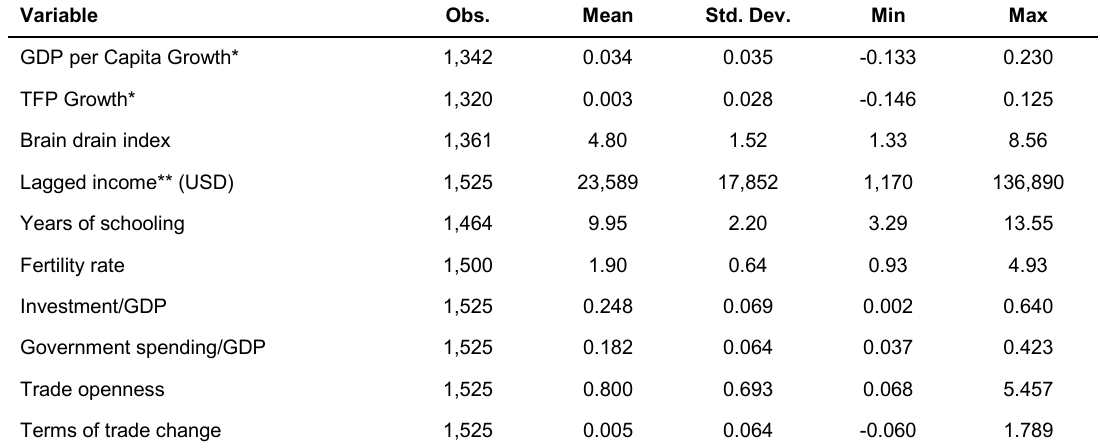
Table 5 . Summary Statistics for Model 1 and Model 4 (1993~2017, 61 Countries).